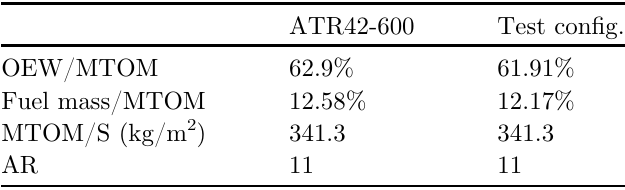
Table 2. Ef fi ciencies of the thermal and electrical chains for serial and parallel hybrid architecture.